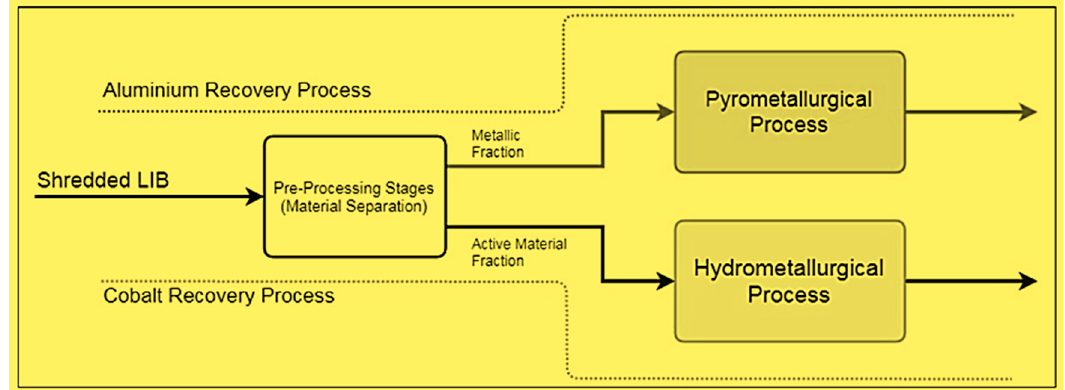
Figure 24. Pyrometallurgical and Hydrothermal Processes